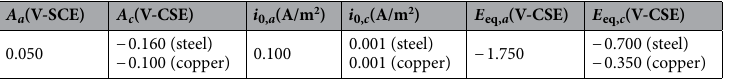
Table 1. Tafel parameters for anode and cathode materials in contact with the soil